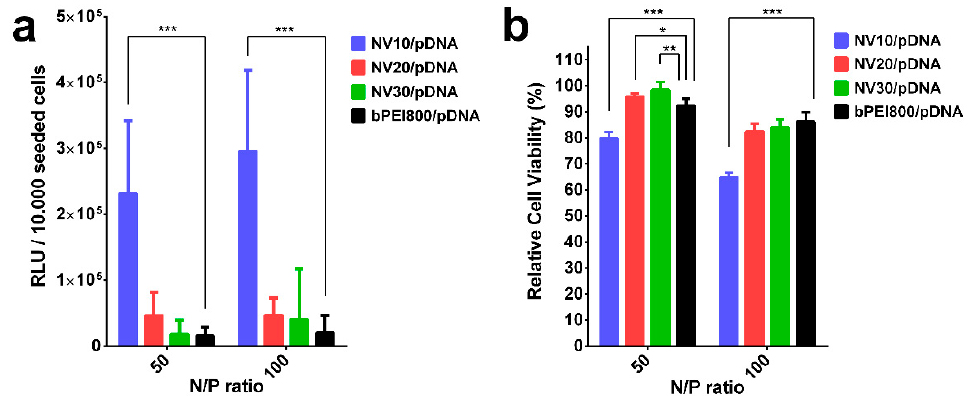
Figure 7. In vitro biological assessments of NV10, NV20, NV30 on HeLa cells: ( a ) Transfection efficiency, ( b ) cytotoxicity. The results are presented as a mean value ± the standard deviation (S.D.); n = 6–8. * p < 0.05, ** p < 0.01, and *** p < 0.001 by Student’s t-test. NV1-NV30 / pDNA polyplexes were formed at N / P ratio 50 and 100 and tested on HeLa cellular